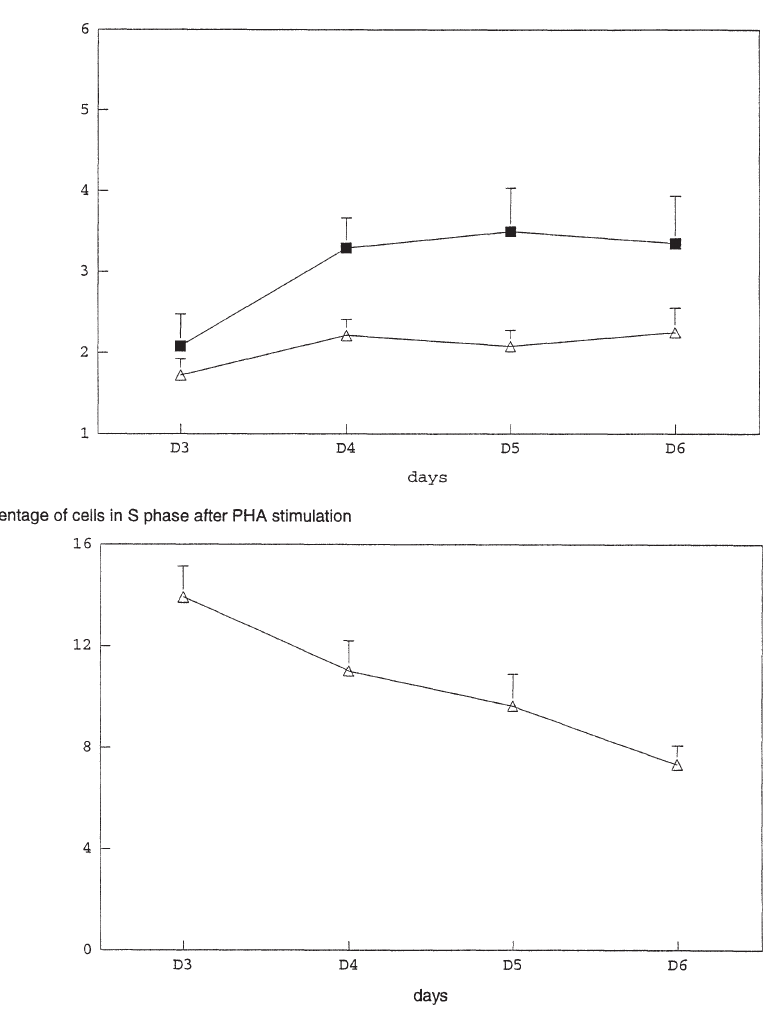
Fig. 2. Mean percentages (topped by S.E.) of peripheral blood mononuclear cells in S phase, assessed in flow cytometry on sequential aliquotes obtained after 3, 4, 5 and 6 days of culture in medium alone ( (cid:52) : control) or with Tetavax (cid:210) ( 2 ) (top panel) or with PHA ( (cid:52) ) (lower panel). These curves only take into account the population of 103 non-anergic patients who showed a significant proliferative response to